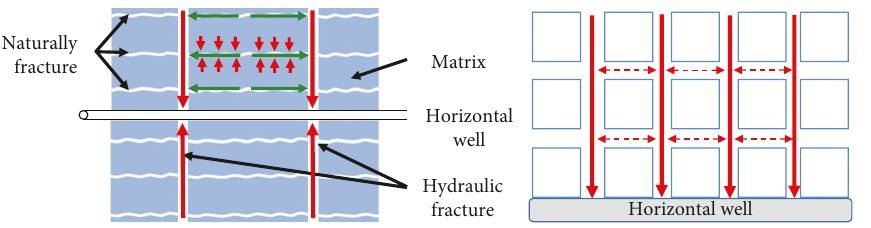
Figure 6: Schematic for contact between matrix and hydraulic-natural fractures.